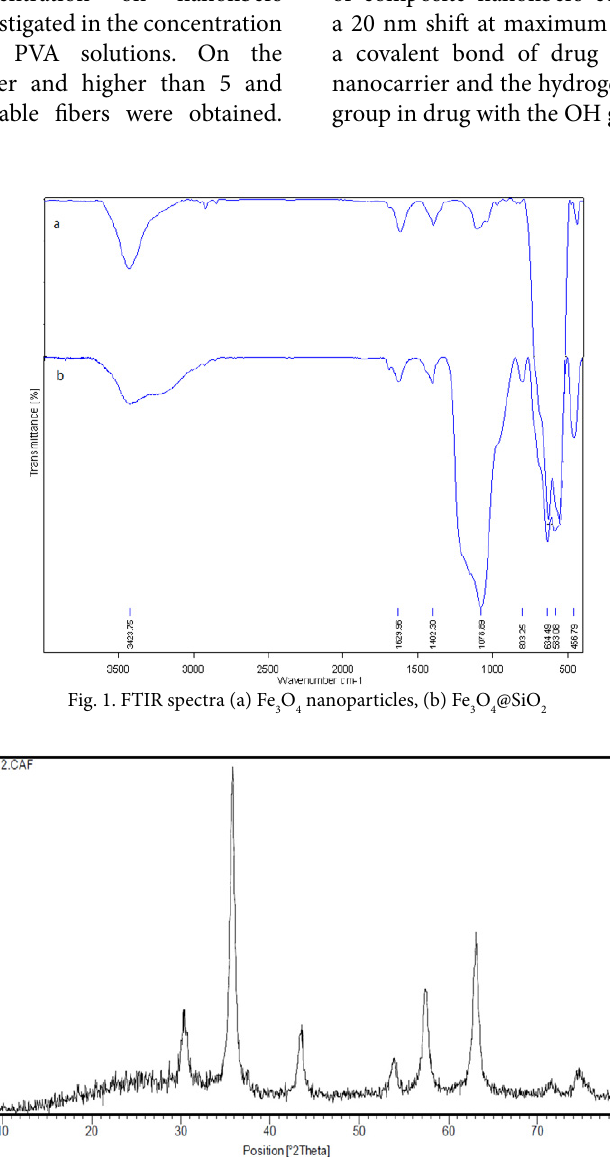
Fig. 2 XRD pattern of Fe 3 O 4 @SiO 2 nanostructure Fig. 2. XRD pattern of Fe